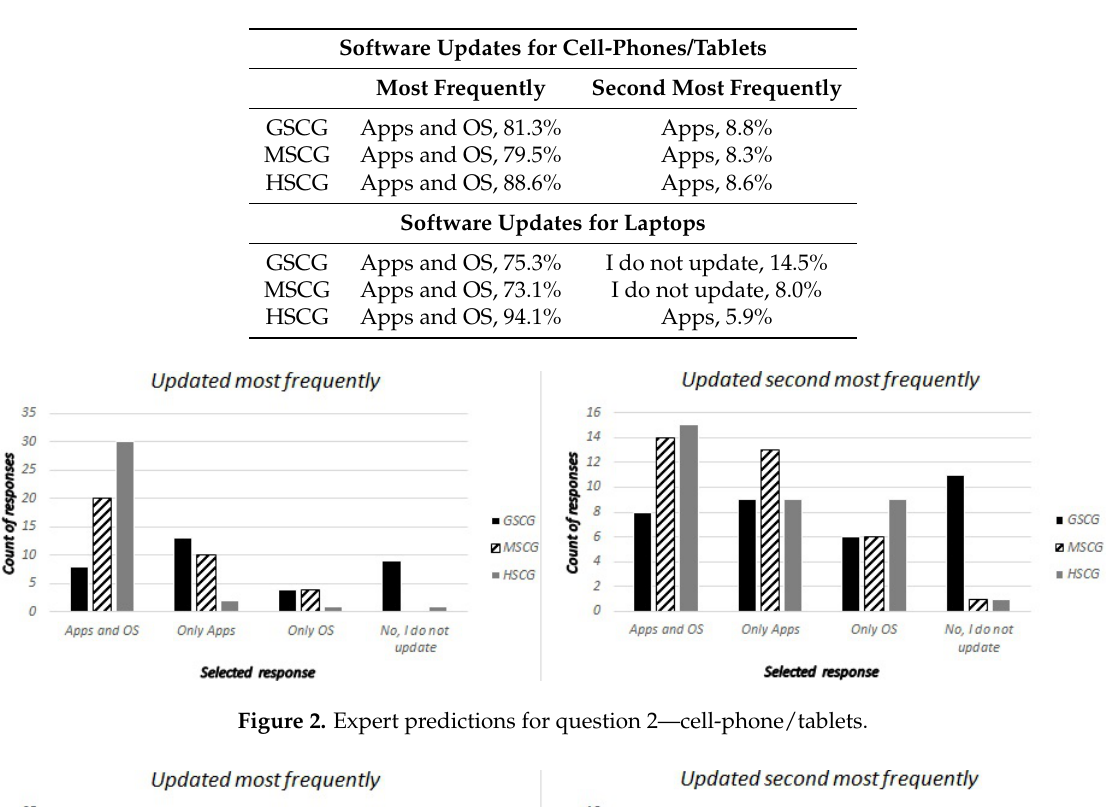
Table 1. First round results for questions 2 and 3; GSCG: general security competence group; MSCG: medium security competence group; HSCG: high-security competence group.